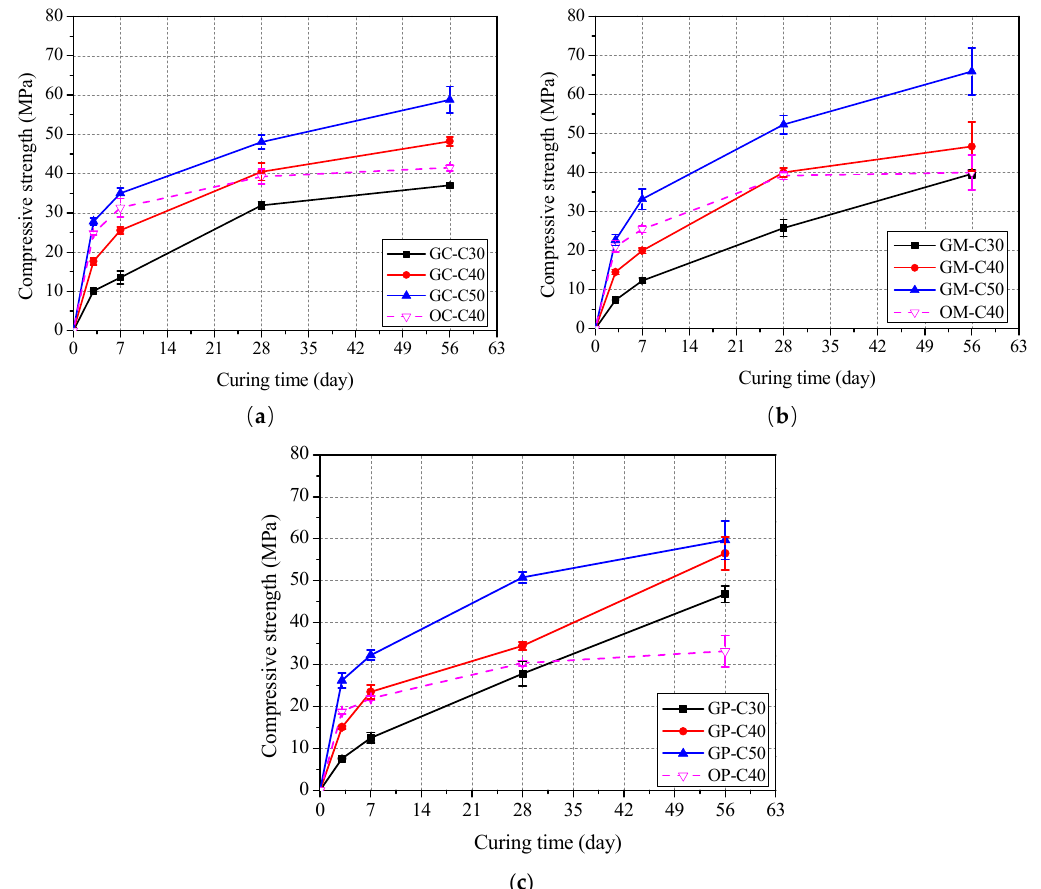
Figure 4. Change of compressive strength of cube specimen with curing time: ( a ) concrete; ( b ) mortar and ( c ) paste. Table 3. Compressive strength of concrete, mortar and paste specimen with curing time.